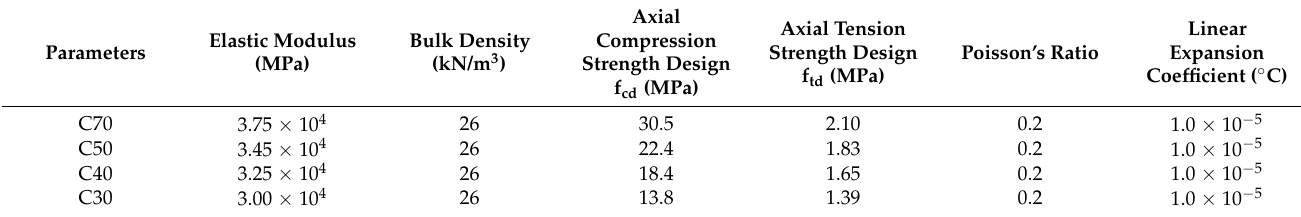
Table 1. Properties of concrete used in this study.